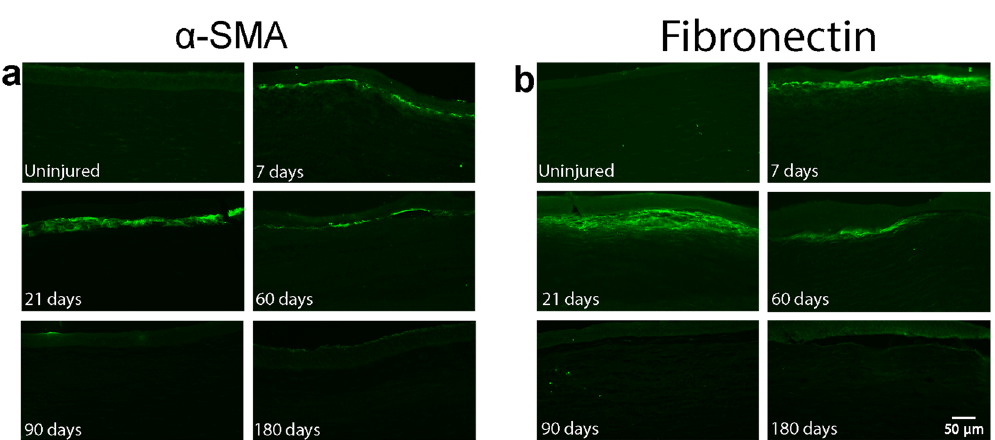
Figure 3. Immunohistochemistry for detection of α -SMA and fibronectin near the center of the photoablated region. ( a ) Contains images from frozen sections labeled for α -SMA, and ( b ) contains images from frozen sections labeled for fibronectin at each time point. Images are from the anterior segment of the